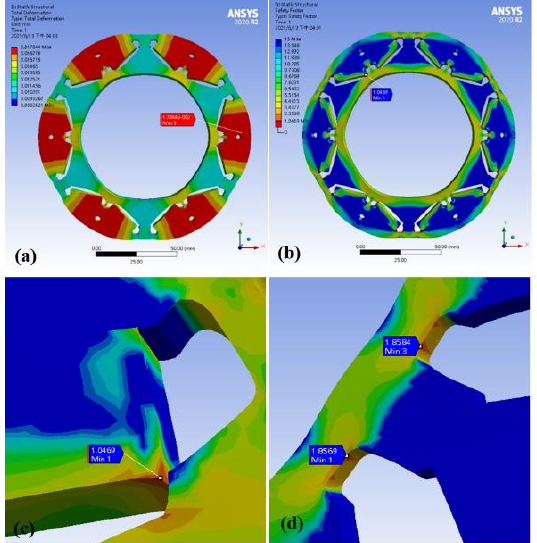
Figure 10. Simulation results for: ( a ) rotor deformation, ( b ) safety factor of rotor assembly, ( c ) mini- mum safety factor in permanent magnet and ( d ) minimum safety factor in rotor.